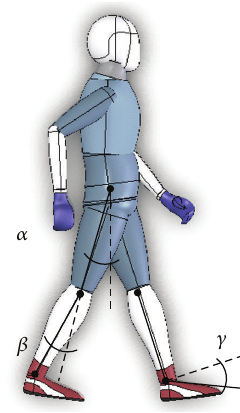
Figure 2: Joint angles definition.